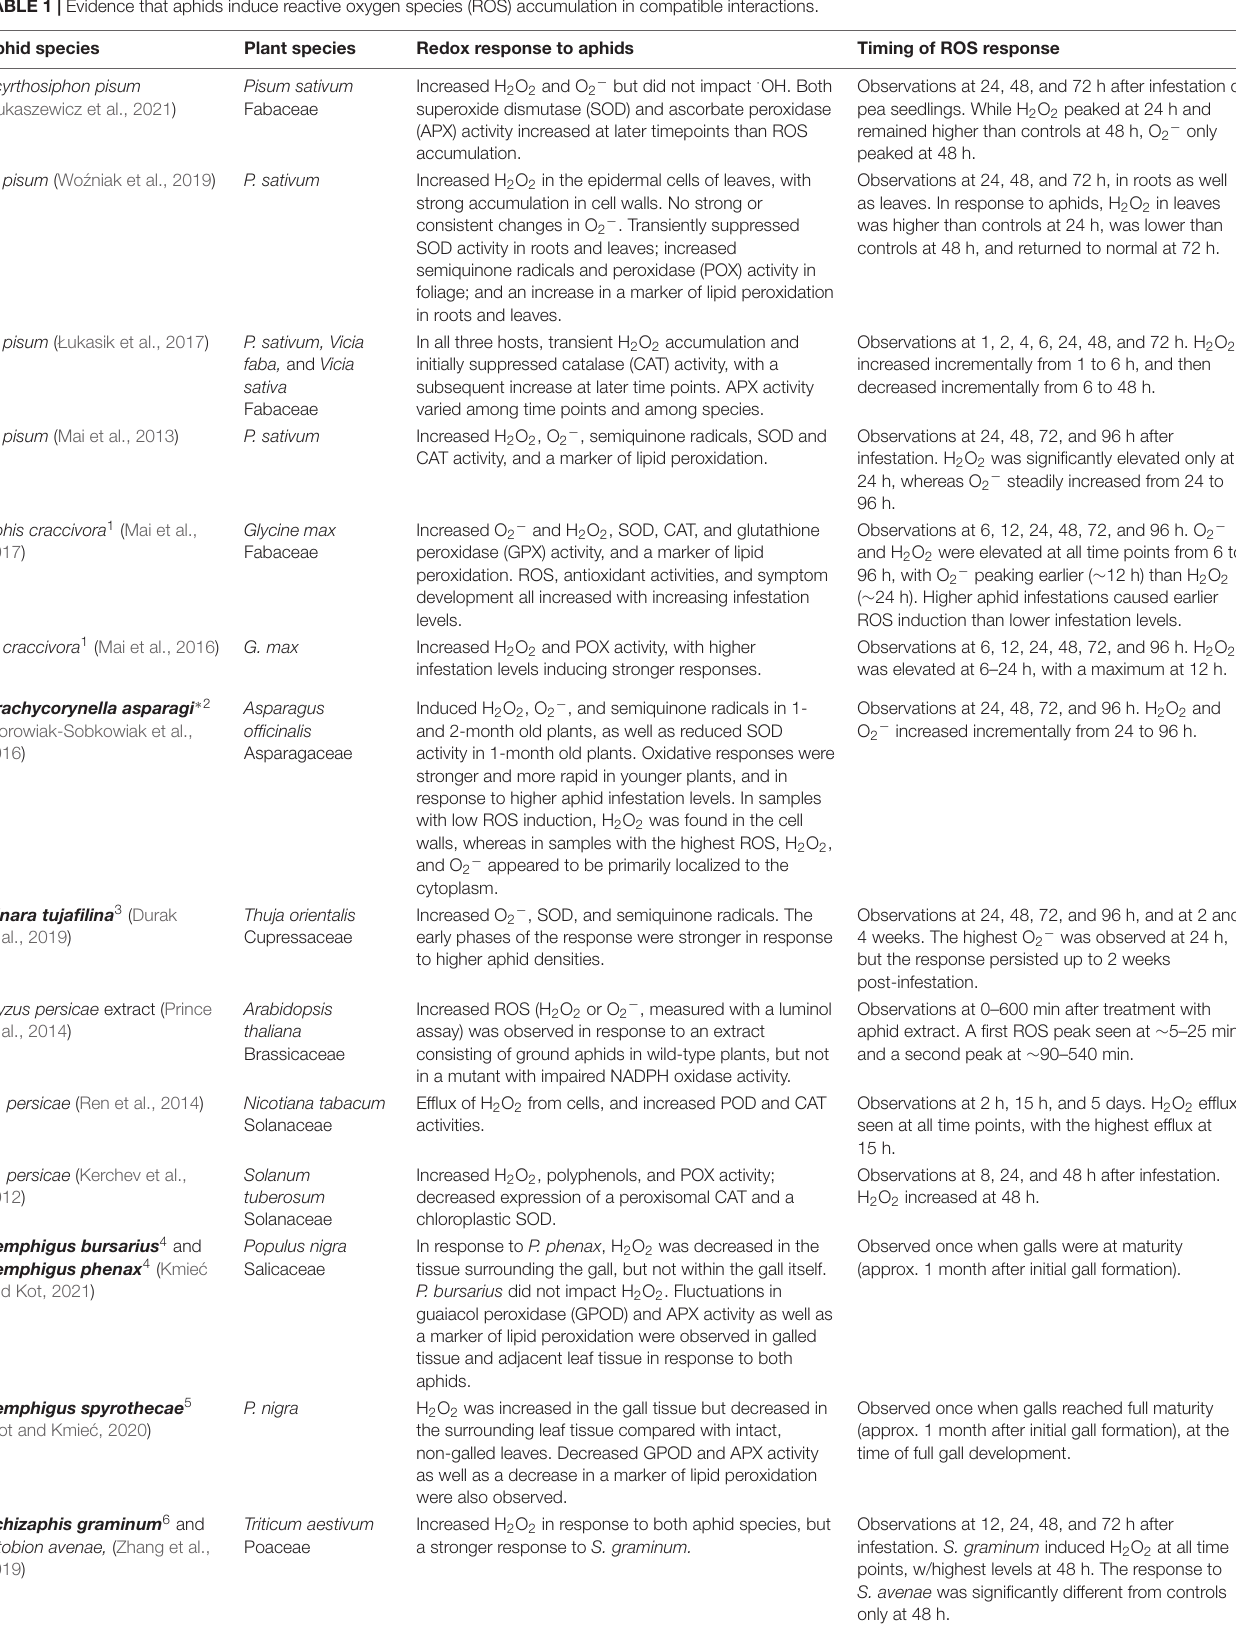
TABLE 1 | Evidence that aphids induce reactive oxygen species (ROS) accumulation in compatible